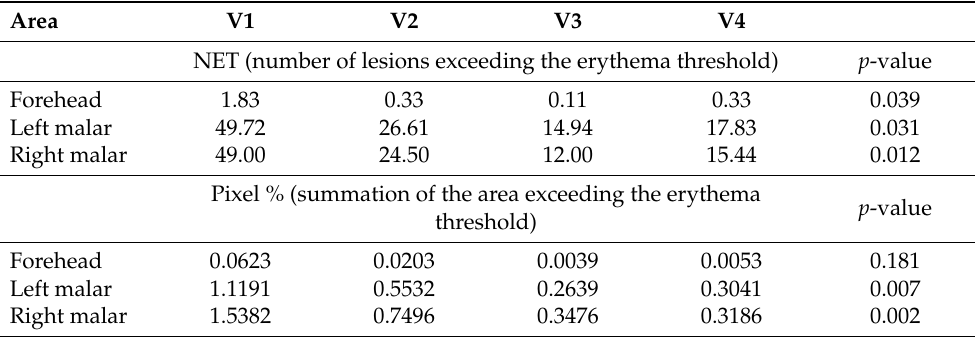
Table 2. Mean NET (number of lesions exceeding the erythema threshold) and Pixel % (summation of the area exceeding the erythema threshold) of acne vulgaris patients at each visit.